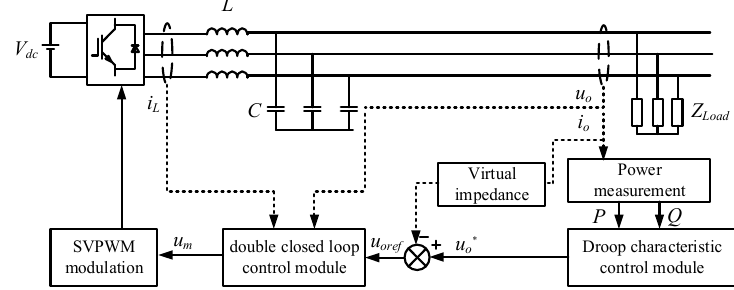
Figure 6 . Structure diagram of the droop control method introducing virtual impedance Figure 6. Structure diagram of the droop control method introducing virtual